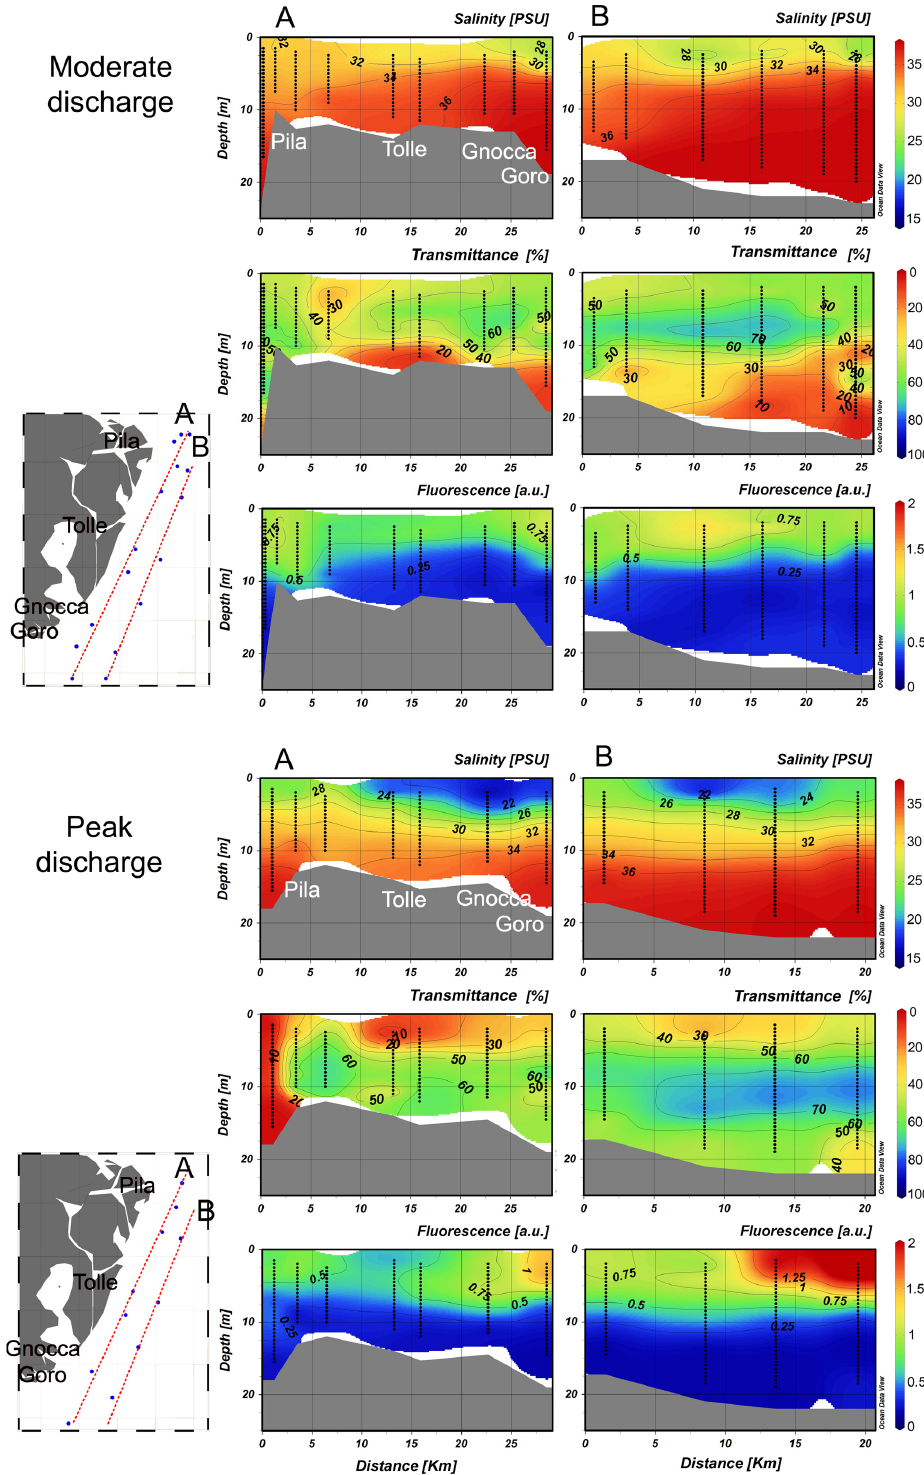
Fig. 5. Salinity, transmittance, and fluorescence in the Po prodelta along two shore-parallel sections during moderate ( ∼ 5000m 3 s − 1 ) and peak discharge ( ∼ 8000m 3 s − 1 )